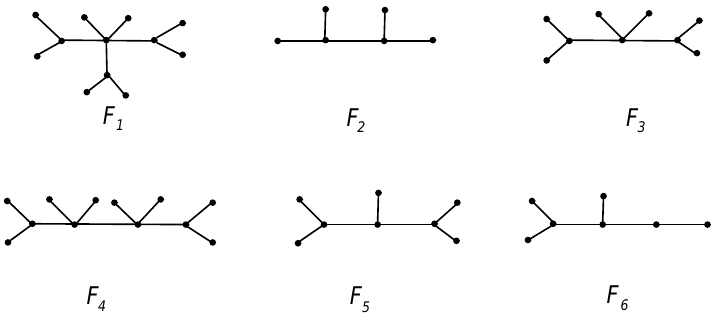
Figure 2. Six trees whose line graphs have no